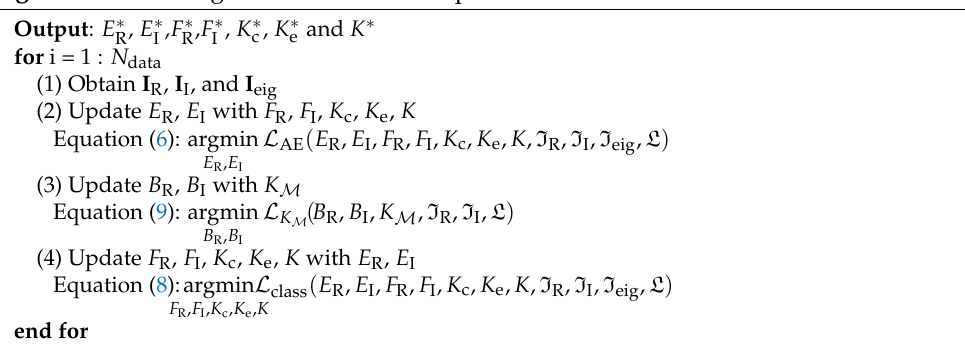
Algorithm 1 Training Procedure for One